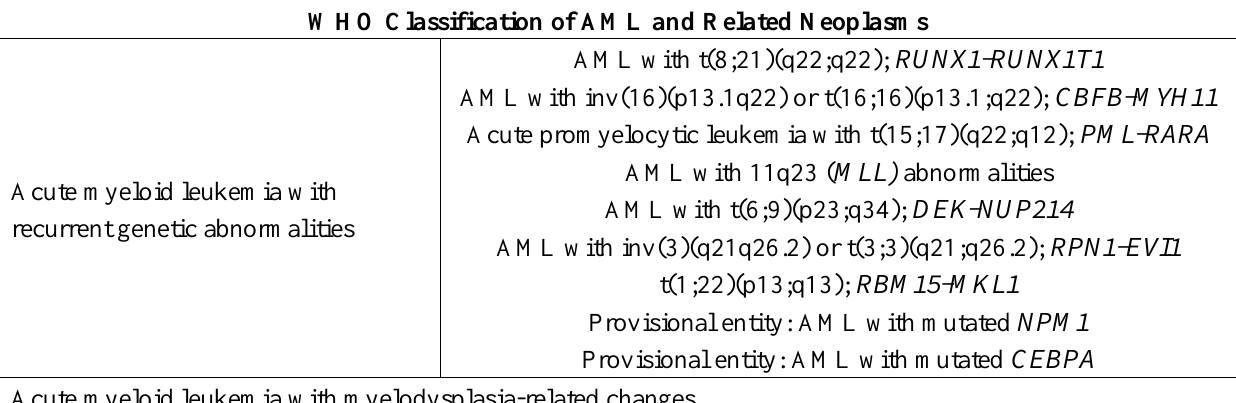
Table 1. The WHO classification of acute myeloid leukemia (AML) and related neoplasms [14]. WHO Classification of AML and Related